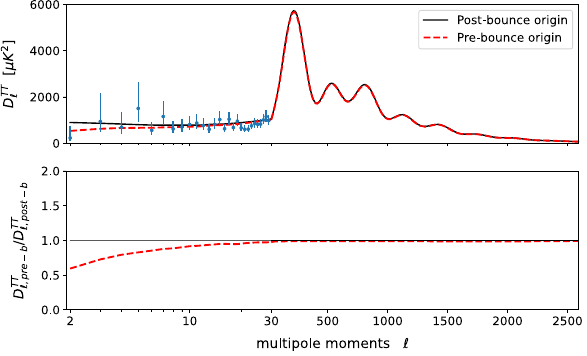
Fig. 12 Temperature angular power spectra D TT (cid:16) for a pre-bounce and for a post-bounce origin of structures, with background IC {− 0 . 5 , + 1 } , and Starobinsky potential. Top: D TT (cid:16), red, Planck data in blue. Bottom: Ratio of the spectra in dashed